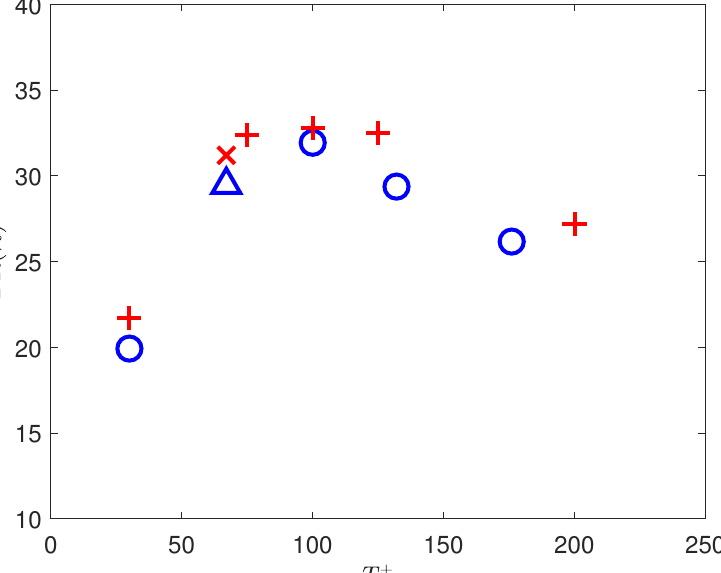
Figure 2. DR for pure temporal forcing with an amplitude of W + m = 12. Blue symbols (circle) from the present boundary layer flow and red (plus) from channel flow (taken from [22]). Red cross (channel) and blue triangle (boundary layer) are for the slightly weaker forcing ( W + m =